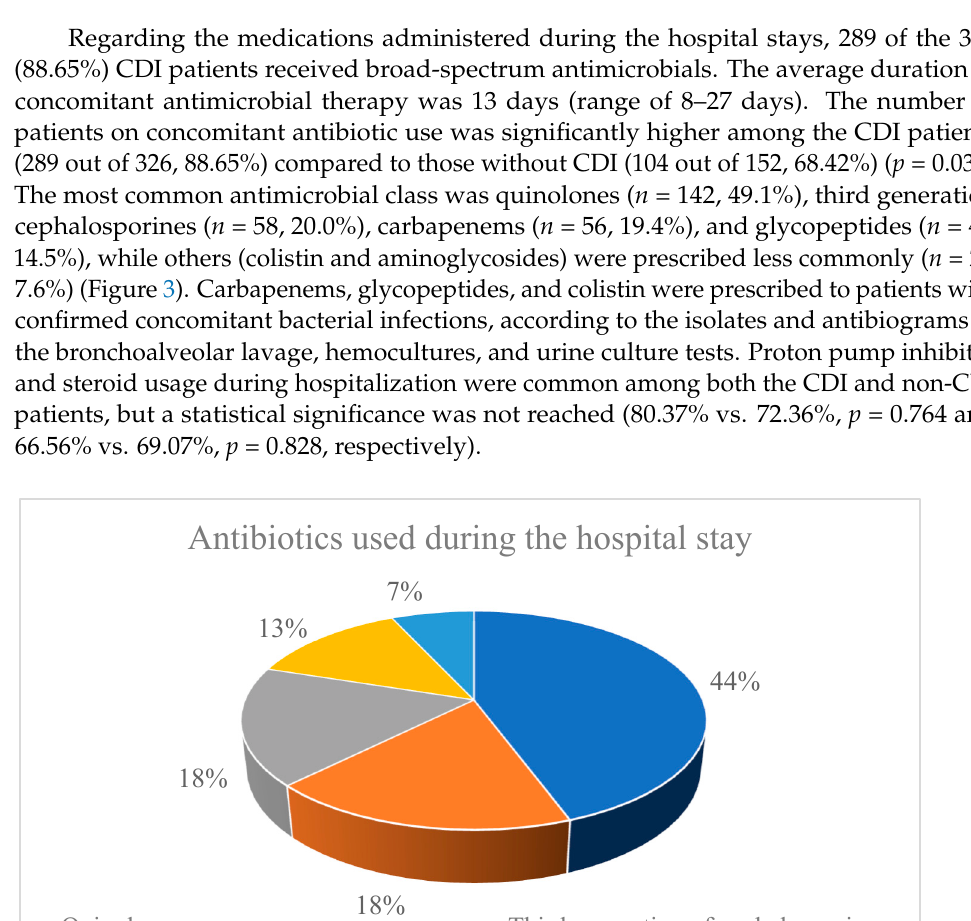
Figure 2. Antibiotics prescribed prior to hospitalization.